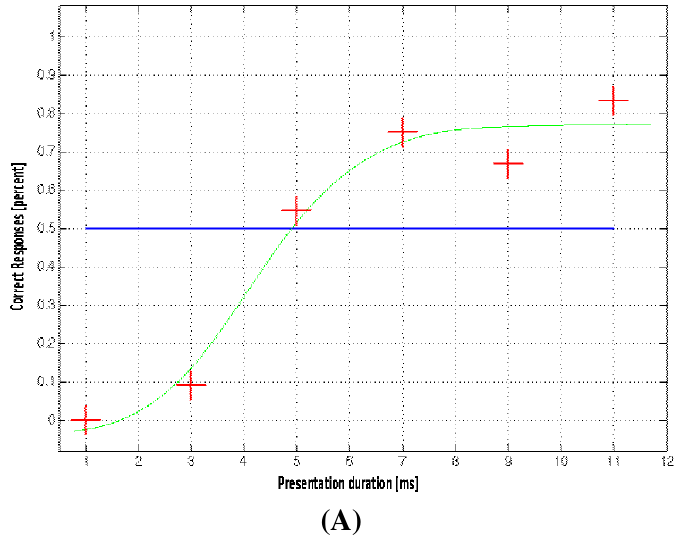
Figure 6. Activations associated with subjective perception. For this analysis a sigmoidal regressor corresponding to the probability with which the faces' gender was detected (A) was used. The sagittal map (B) shows significant BOLD-signal increases projected onto the anatomical brain image of the particular subject (p < 0.05